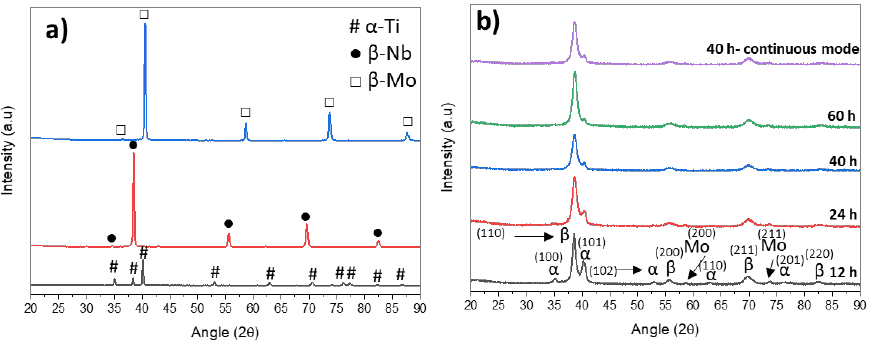
Figure 2. The XRD profiles for the ( a ) precursor powders and ( b ) TiNbMo powders milled for 12 h, 24 h, 40 h, 60 h and 40 h in the continuous mode.